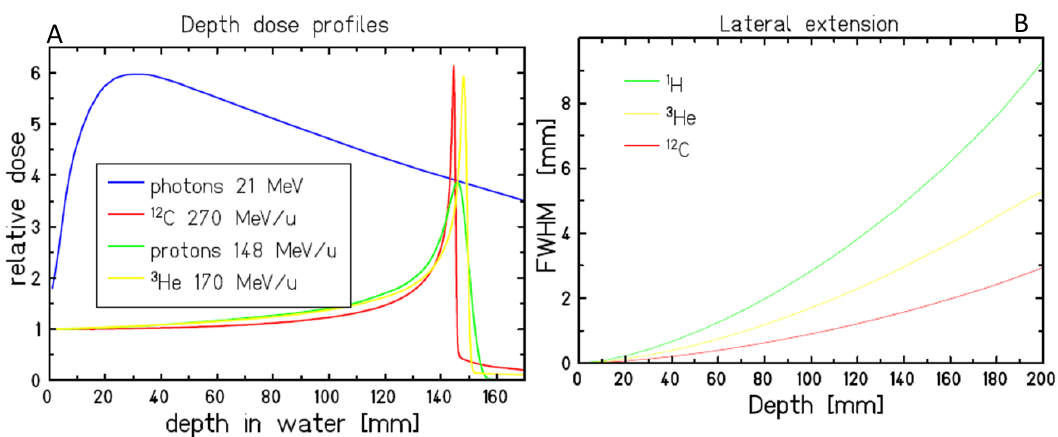
Figure 1. Physical properties of carbon ions in comparison to X-rays, protons, and helium ions. ( A ). Depth-dose distributions showing the Bragg peak for all ions at the same range, and the reduced straggling of heavier ions. ( B ). Lateral scattering is reduced by increasing the ion mass.